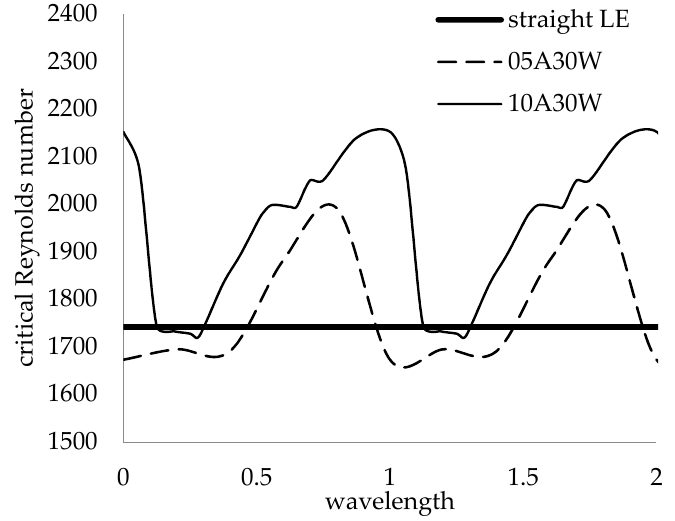
Fluids 2020 , 5 , x Figure 23. Global critical Reynolds number profile for fixed 30% wavelength and variable amplitudes.